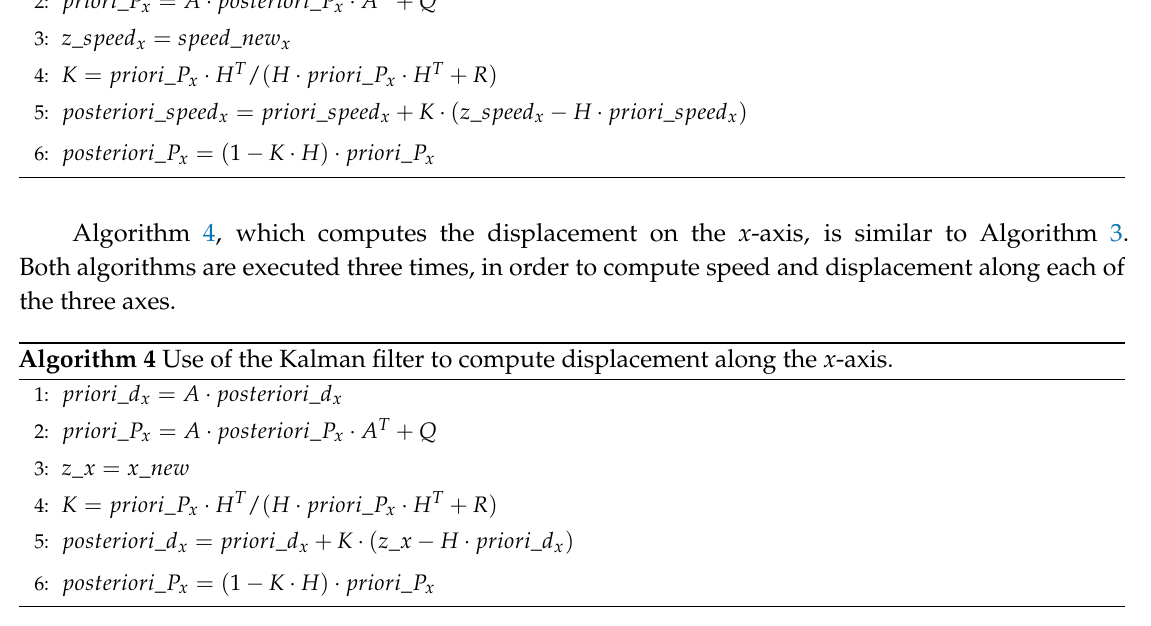
Algorithm 3 Use of the Kalman filter to compute speed along the x -axis.